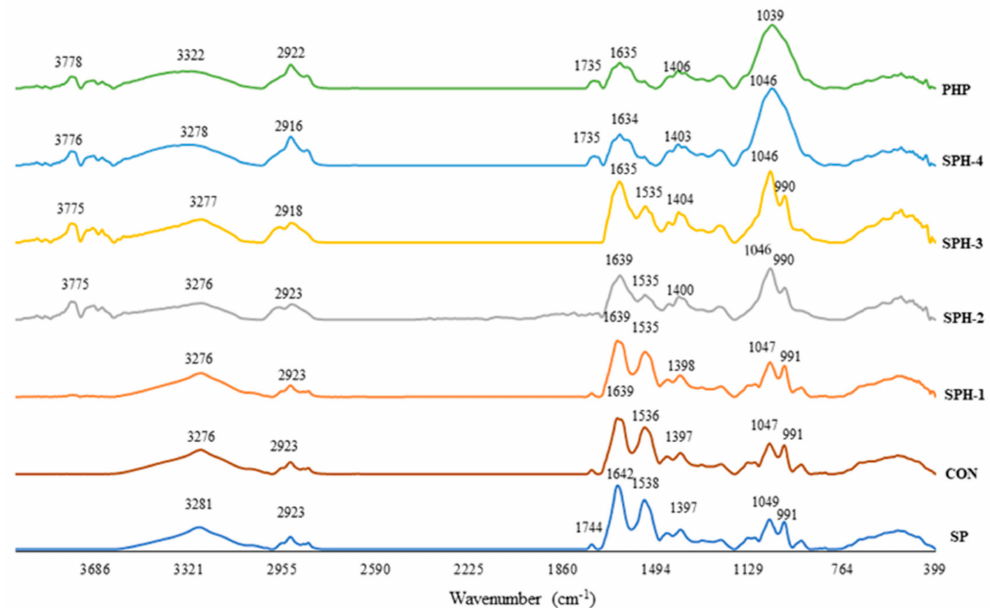
Figure 5. FTIR spectra of threadfin bream surimi gel added without and with psyllium husk at different levels. SP: surimi paste, PHP: psyllium husk powder. Caption: See Figure